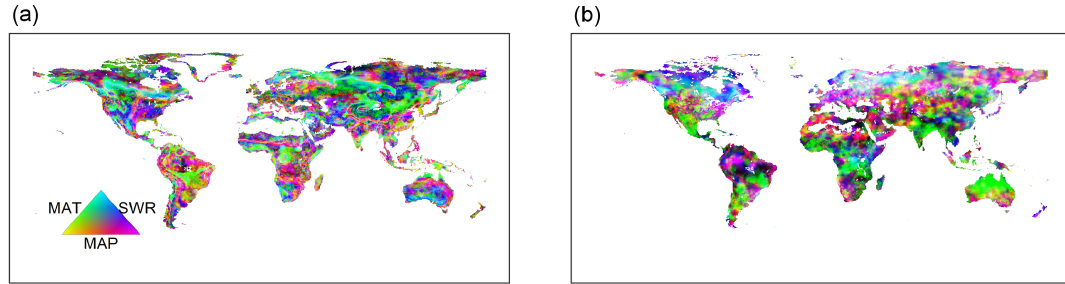
Figure 9. Dominant driving factors for RF-RA (a) and Hashimoto2015-RA (b) . MAT is mean annual temperature, MAP is mean annual precipitation and SWR is shortwave radiation.